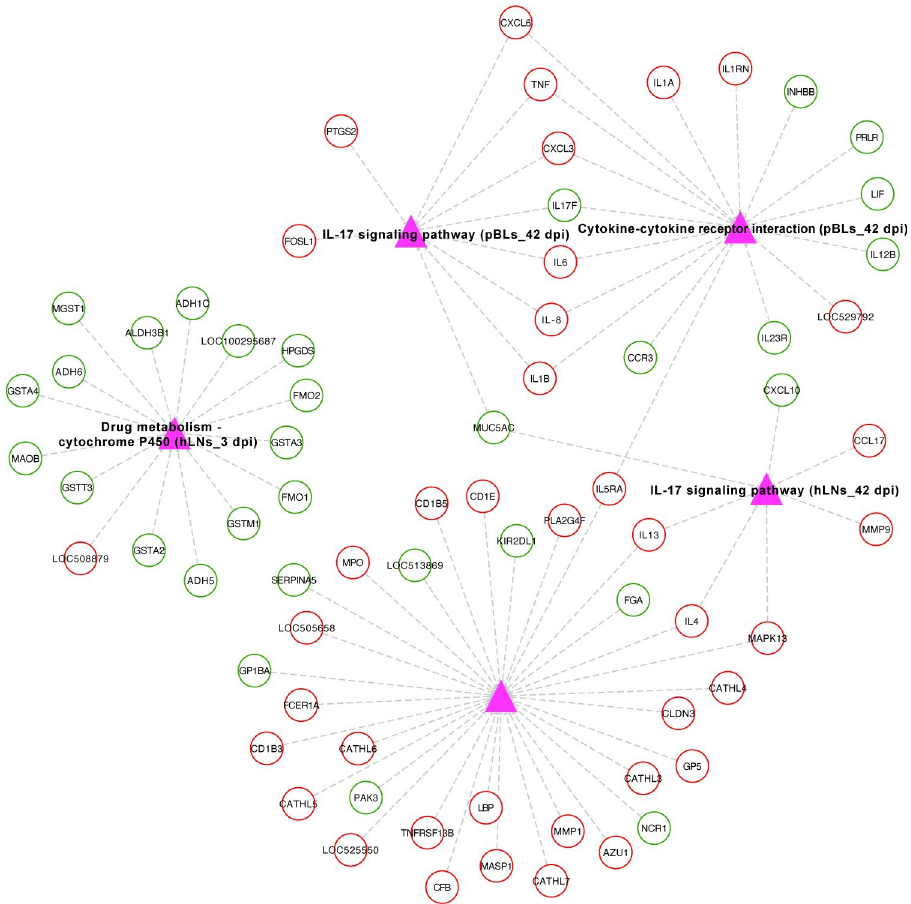
Fig 3. Differentially expressed components of four of interesting pathways involved in immune response and drug metabolism in F . gigantica -infected hLNs and pBLs. Pink triangle represents the pathway name, and circle represents the gene name, of which red circle represents the upregulated transcripts in infected tissues and blue circle represents the downregulated transcripts.